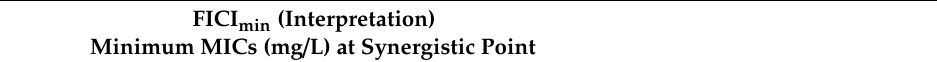
Table 2. Checkerboard synergy testing results for the combinations of linezolid with several antibiotics against staphylococcal isolates: 5 S. aureus (Sa) and 5 S. epidermidis